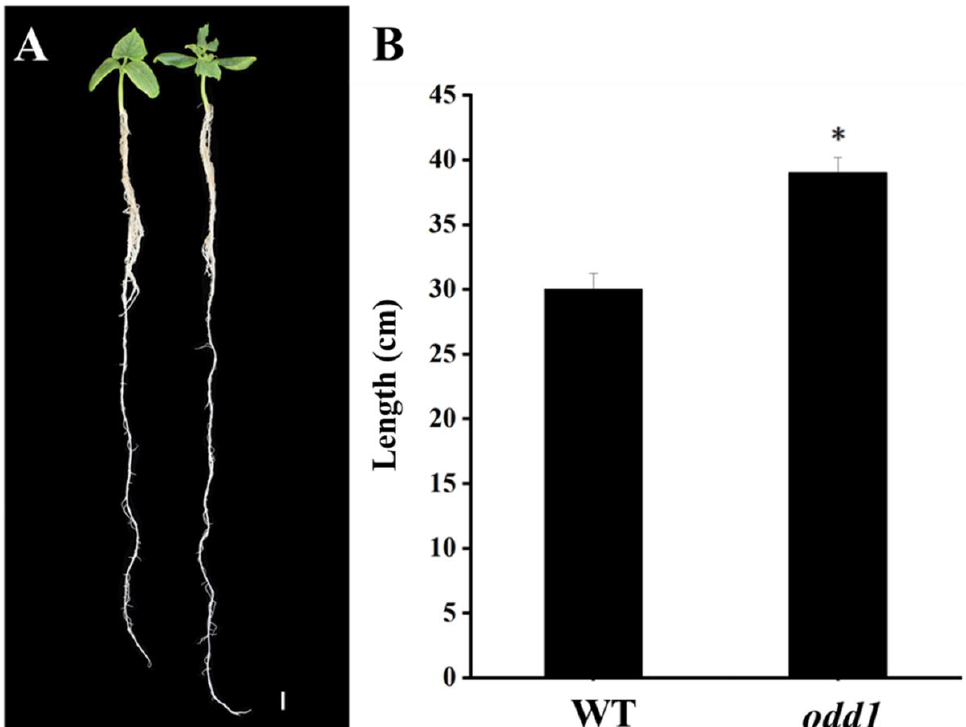
Figure 4 Figure 4. Phenotypic features of stem and fruit of odd1 . ( A ) The contrast of stems and their transverse sections between WT (left) and odd1 (right) at same developmental stage. ( B ) The mature fruits of WT (left) and odd1 (right), respectively. ( C ) Fruit growth curves of odd1 and WT. DBA. Days before anthesis. DAA. Days after anthesis. Scale bars represent 1 cm.